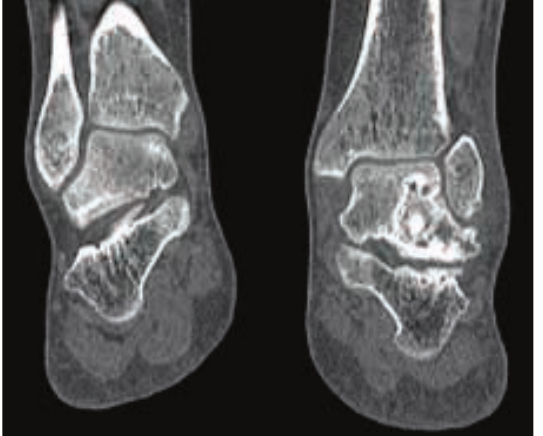
Figure 9: Immediate post-operative antero-posterior plain radio- graph demonstrating filling the void with CERAMENT after curettage of the GCT of the talus.